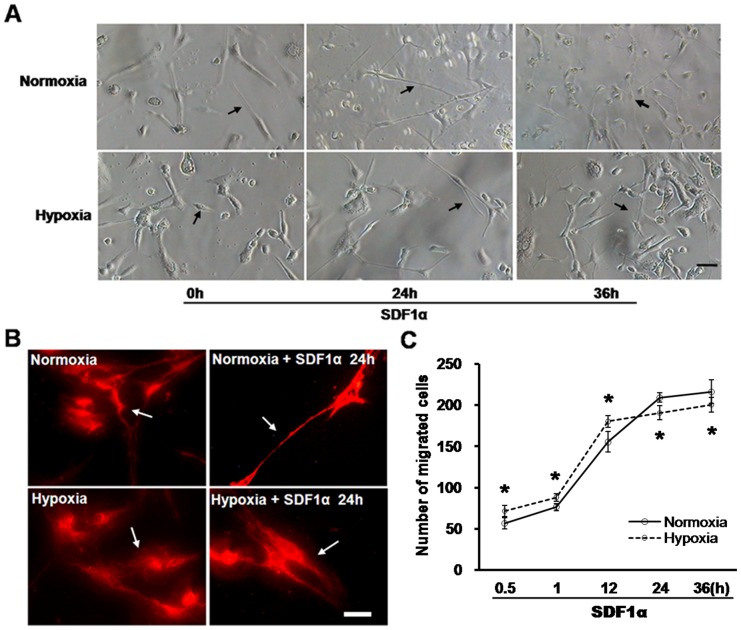
Effects of SDF1α on cell morphology, actin filament polymerization and migration capability after hypoxia.Adhered hippocampal cells were exposed to hypoxia or left untreated (normoxia) on the seventh day of culturing. Then SDF1α (50 ng/ml) was added to medium for 0.5, 1, 12, 24, and 36 hours. A, Cell morphological changes were observed in normoxia and hypoxia with 24 or 36 h stimulation of SDF1α or not. Arrow heads indicate the changes of morphology. Bar = 50 µm. B, Actin filament polymerization was measured by Alexa Fluor 546-conjugated phalloidin under normoxia or hypoxia with SDF1α for 24 h or not. Distribution changes of actin filament polymerization are indicated by arrows. Bar = 50 µm. C, Cell migration induced by SDF1α was determined by a transwell chamber assay. *P<0.01, vs normoxia.